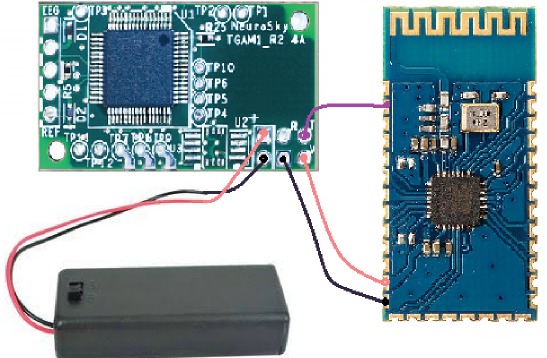
Figure 3. Electroencephalographic Biosensing System: ThinkGear ASIC Module 1 (TGAM1) and B26782H Bluetooth